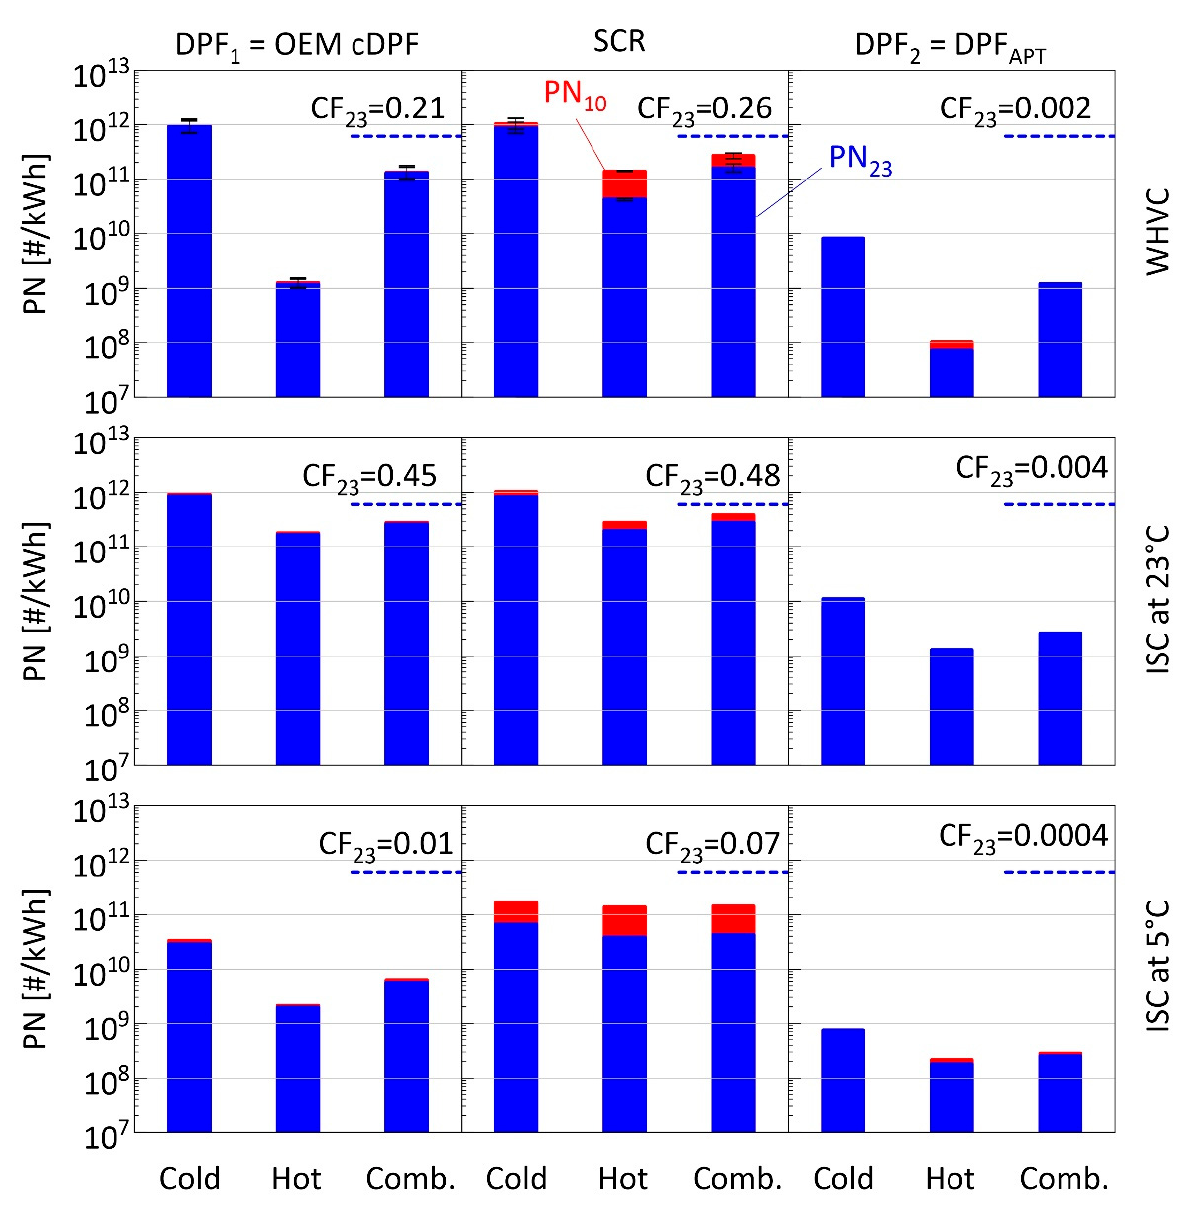
Figure 3. Summary of Particle Number (PN) emissions following the Euro VI Step E evaluation methodology, for the tests where the OEM cDPF was used. Charts on the left, middle and right planes correspond to emission levels at DPF 1 out, SCR and DPF 2 out positions, respectively. Charts on the top, middle and bottom planes correspond to WHVC, ISC at 23 ◦ C and ISC at 5 ◦ C tests, respectively. Blue bars correspond to SPN 23 while red bars correspond to SPN 10 . The error-bars indicate the maximum and minimum emissions, while the dashed lines indicate the applicable limit (6 × 10 11 #/kWh), while the numbers on top represent the conformity factor (ratio of average emissions over applicable limit). APT = Accelerated Purification Technology; cDPF = Catalyzed DPF; CF = Conformity Factor; DPF = Diesel Particulate Filter; ISC = In-Service Conformity Cycle; OEM = Original Equipment Manufacturer; SCR = Selective Catalytic Reduction; WHVC = Worldwide Harmonized Vehicle Cycle.